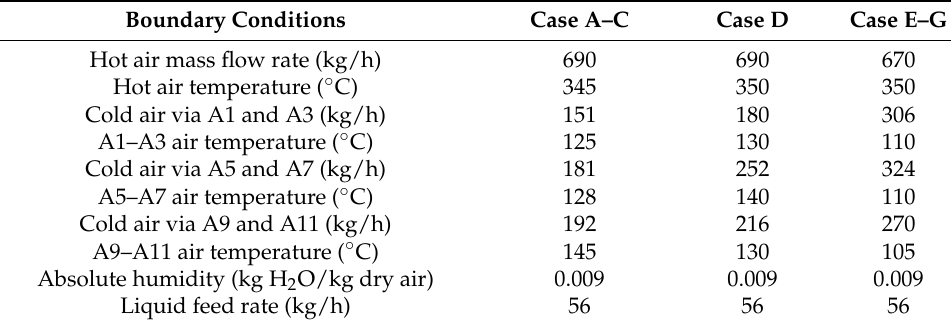
Table 1. Boundary conditions for all simulation cases.